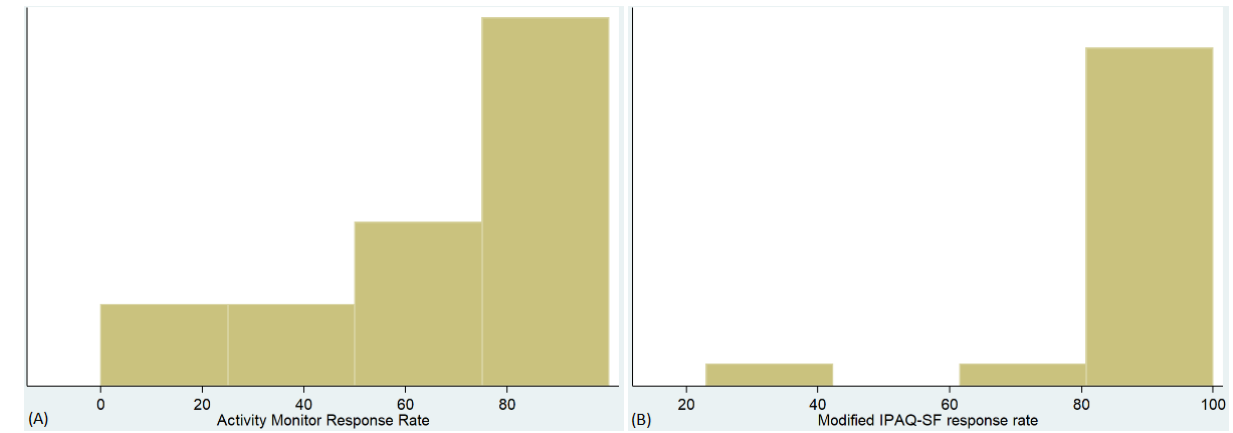
Figure 2. Histogram of adherence rate and response rate to (A) activity monitor (B) modified IPAQ. IPAQ-SF: International Physical Activity Questionnaire Short